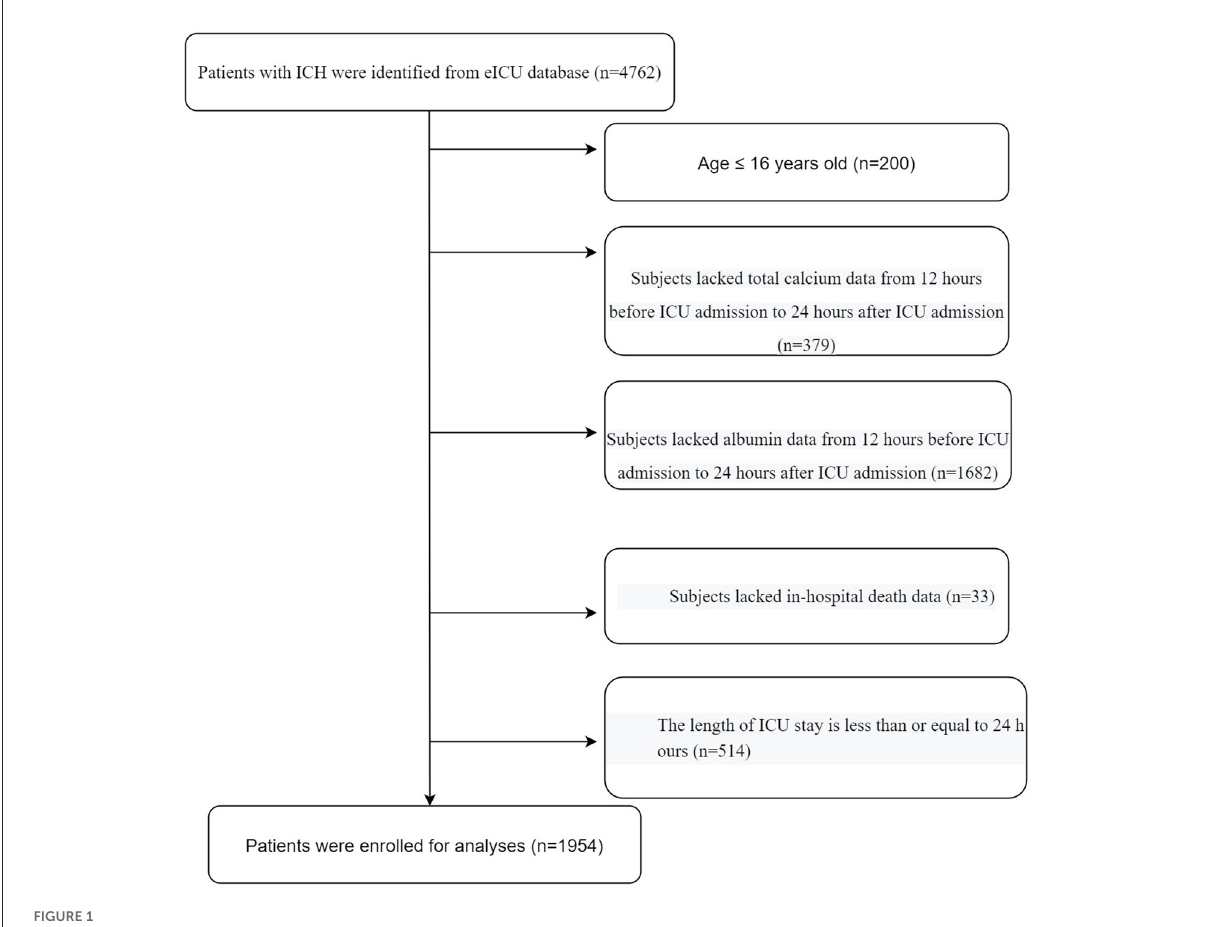
FIGURE1 Flow chart of